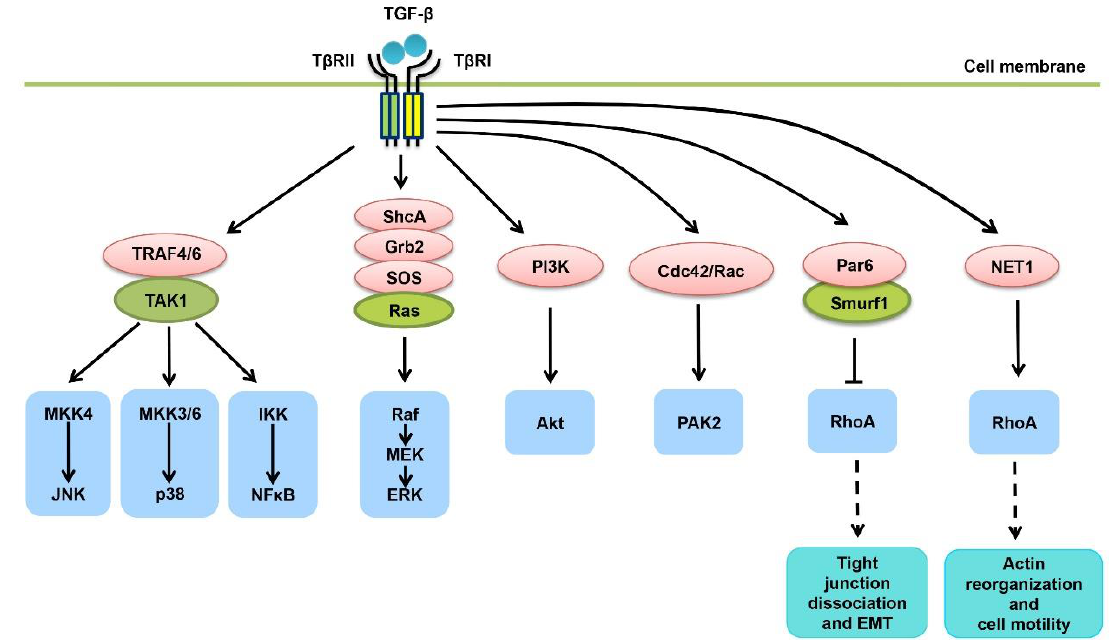
Figure 2. TGF-β activates versatile non-Smad pathways . Ligand-bound TGF-β receptors activate Figure 2. TGF- β activates versatile non-Smad pathways. Ligand-bound TGF- β receptors activate